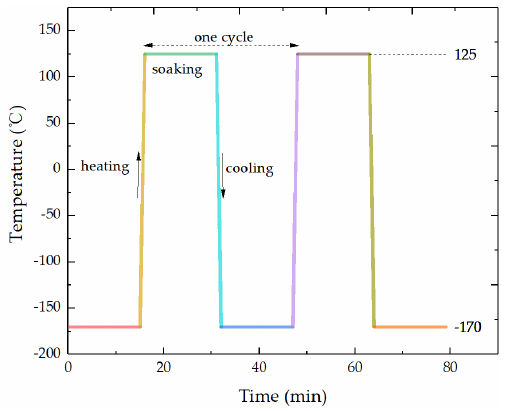
Figure 3. Thermal shock profile for the test application.